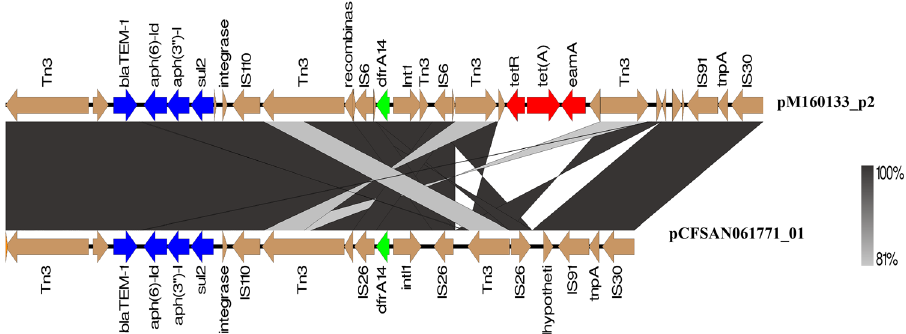
Figure 6. Linear maps of the multidrug resistance regions of pCFSAN061771_01 and pM160133_p2. Antimicrobial resistance genes are shown in red, green and blue. Mobile elements are shown in brown. Homologous segments with ≥ 99% sequence identity are indicated by black shading, while gray shading shows inverted homologous